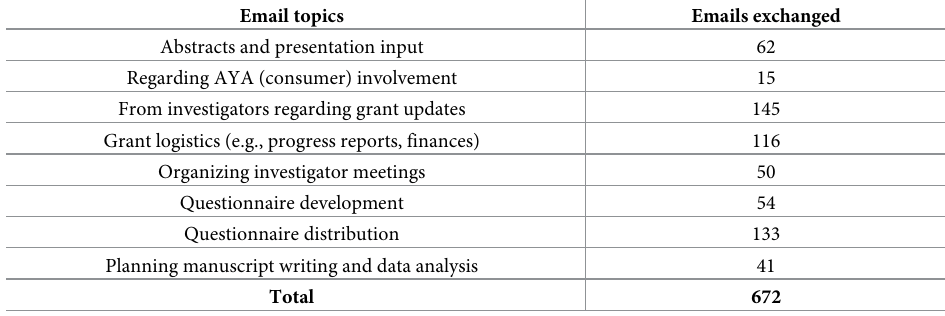
Table 1. Counts of group-level emails exchanged between two or more investigators by project topics as at June